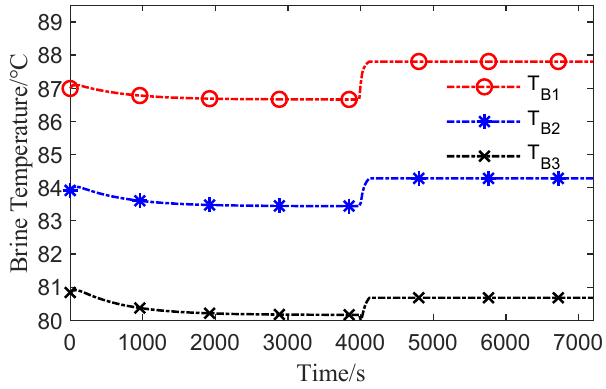
Figure 29. Dynamic of BBT for step increase in